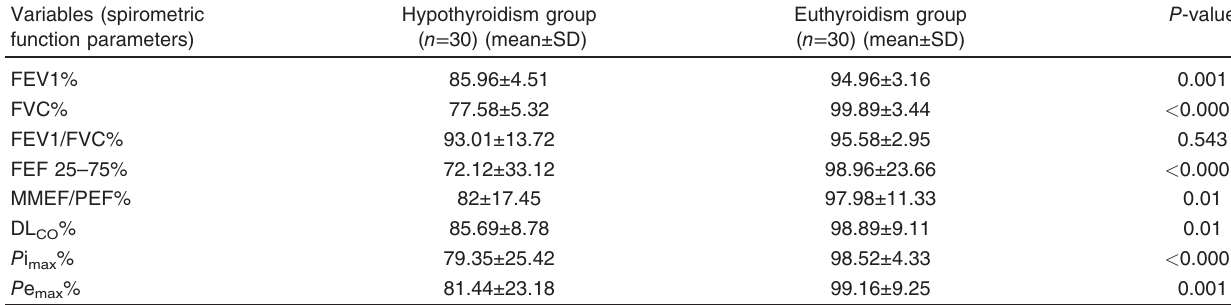
Table 4 Comparison of spirometric function parameters between hypothyroid and euthyroid groups Variables (spirometric function